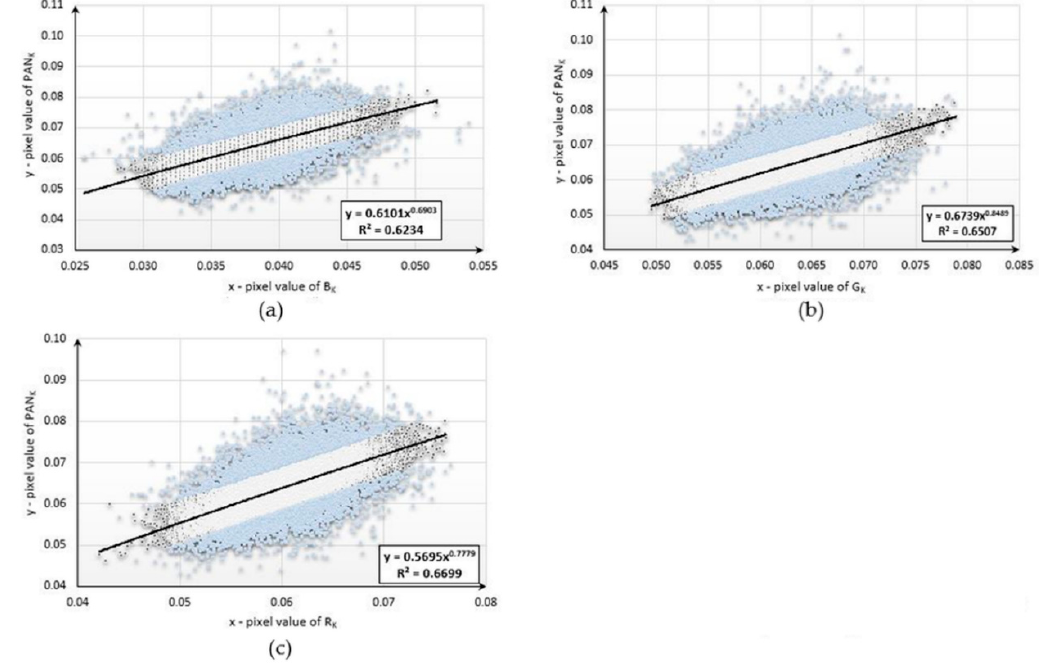
Figure 5. Diagrams presenting the functional relationships for the mowed meadow sample: ( a ) between PAN and red bands; ( b ) between PAN and green bands; ( c ) between PAN and blue bands.